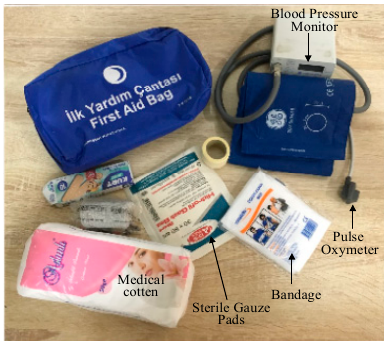
Figure 3. First aid kit with contents.